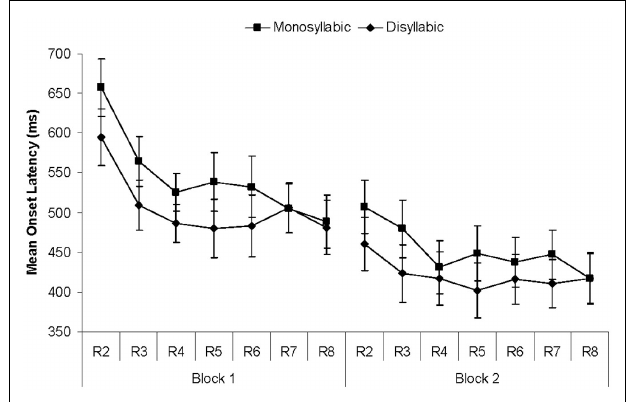
FIGURE 2 | Results of Experiment 1. Mean utterance onset latencies (ms) per block and repetition (R2 through R8) for monosyllabic and disyllabic items. Error bars show SEs.